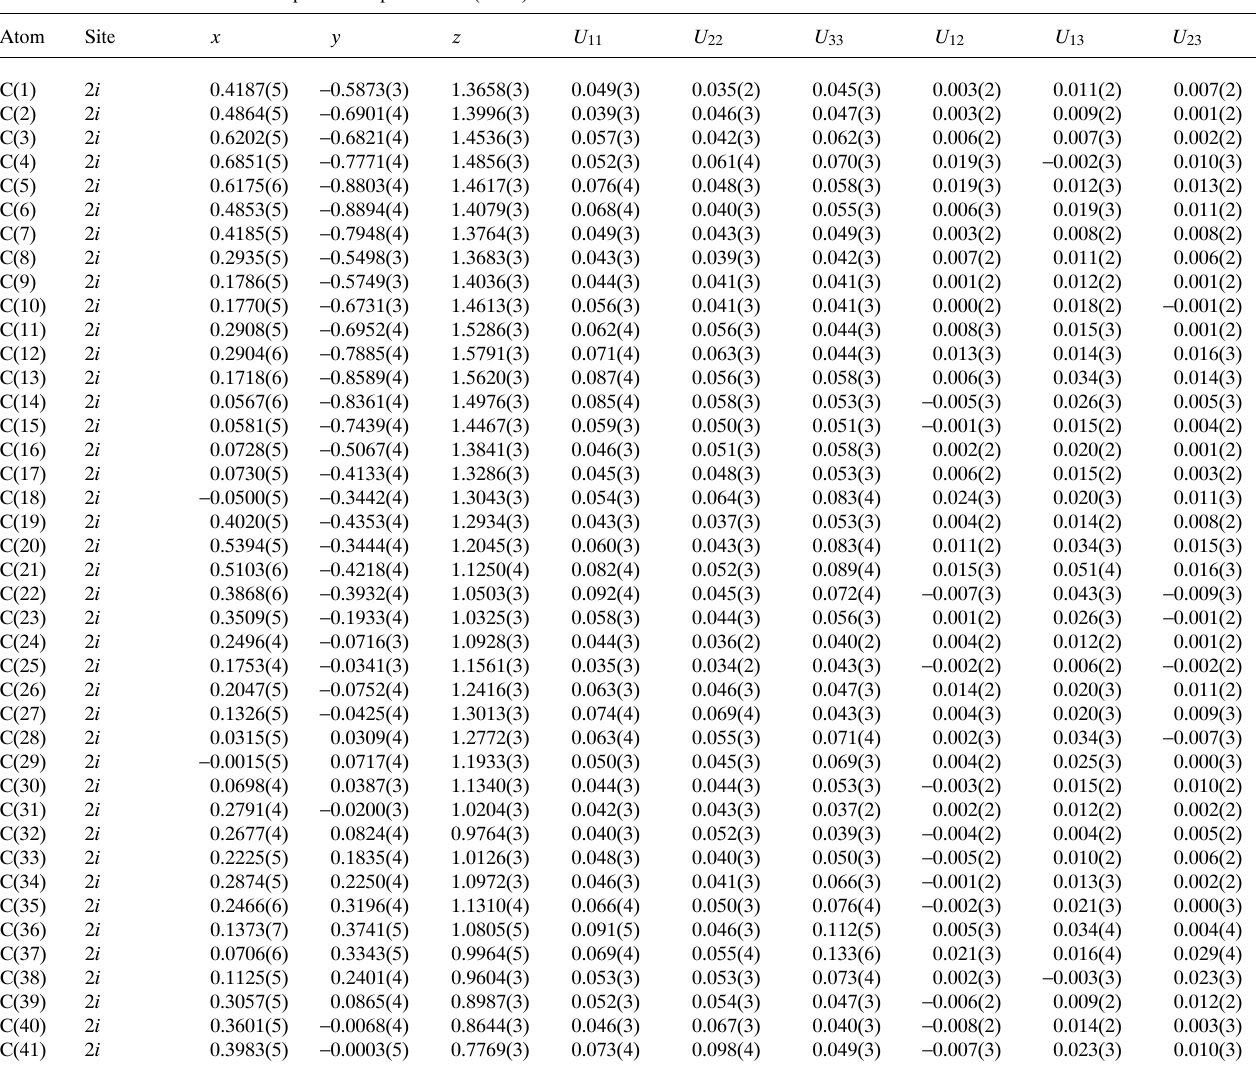
Table 3. A tomic coordin a tes a nd displ a cement p a r a meters (in Å 2 ) .